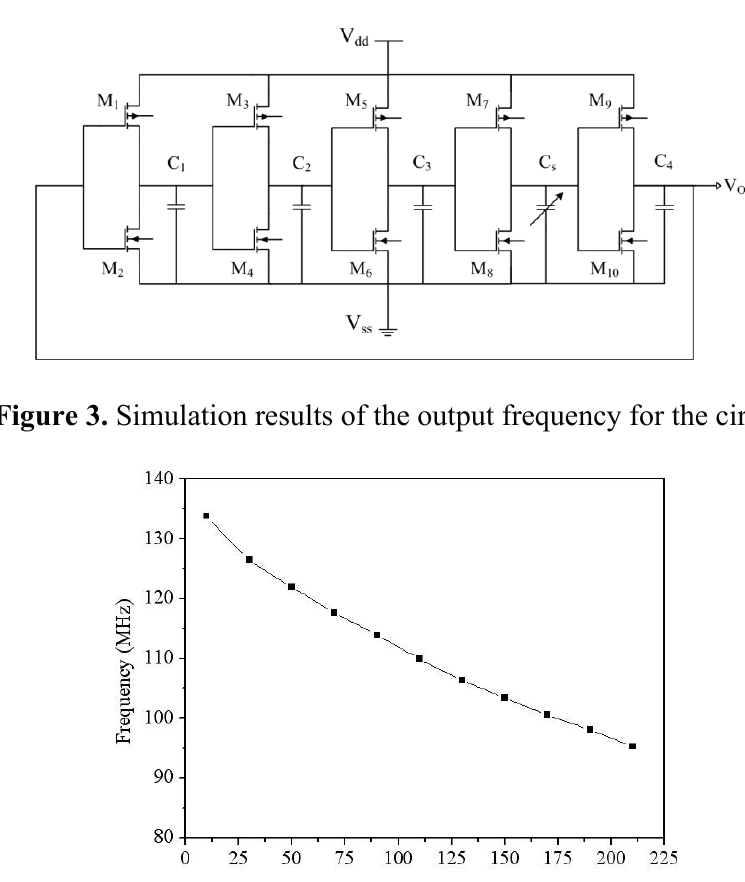
Figure 2. Ring oscillator circuit for the acetone microsensor.